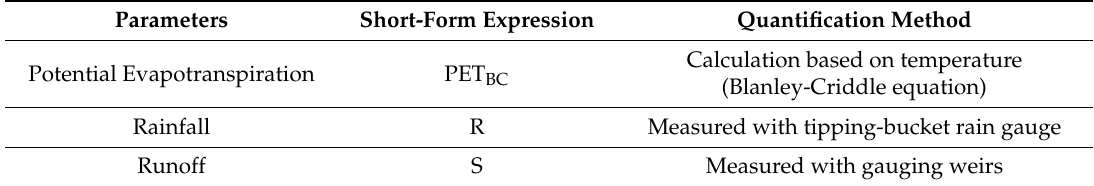
Table 2. Entry parameters of the water budget